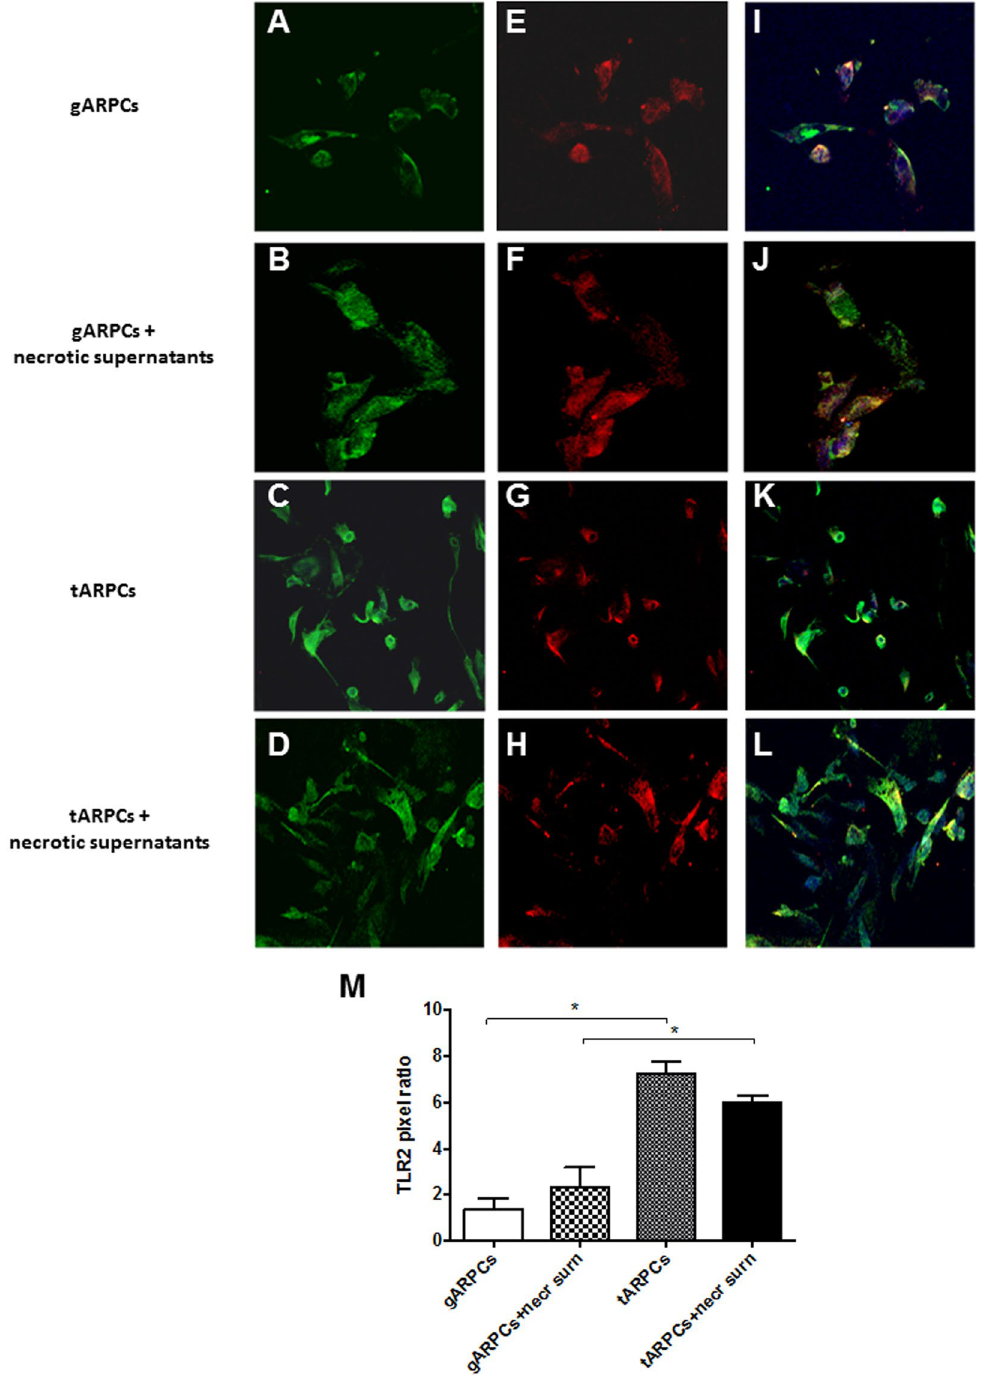
Figure 5. Difference of TLR2 expression in gARPCs and tARPCs following exposure to necrotic cell supernatants. Immunofluorescence experiments on ARPCs showing the TLR2 expression at basal conditions and after exposure to necrotic cell supernatants. ( A – D ) immunofluorescence showed the expression of TLR2 (green) in gARPCs, gARPCs + necrotic supernatant, tARPCs, and tARPCs + necrotic supernatans, respectively. ( E – H ) Immunofluorescence showed the expression of CD133 (red) in gARPCs, gARPCs + necrotic supernatant, tARPCs, and tARPCs + necrotic supernatants, respectively. ( I – L ) Double-label immunofluorescence showed the expression of TLR2 (green) and CD133 (red) in gARPCs, gARPCs + necrotic supernatant, tARPCs, and tARPCs + necrotic supernatant, respectively. Nuclei were stained with TO-PRO-3 (blue). Original magnification 40x. ( M ) Quantification of TLR2 expression by calculating the pixel ratio of positive cells in 10 different fields. TLR2 expression was significantly higher in tARPCs in basal condition and following exposure to necrotic cell supernatants. Reprinted from [Kidney International] 46 , Supplementary Figure S5, Copyright (2013), with permission from